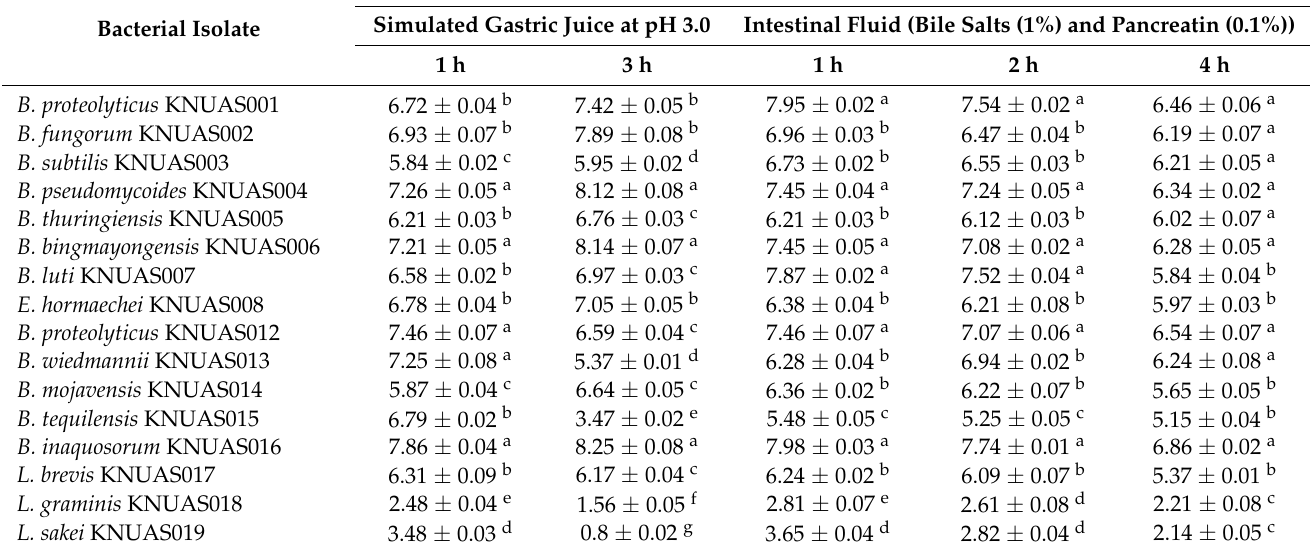
Table 2. Tolerance of isolated bacterial strains from fermented Korean foods to simulated gastric juice and intestinal fluid. The different superscript letters follow values indicating the significance among the samples ( p <